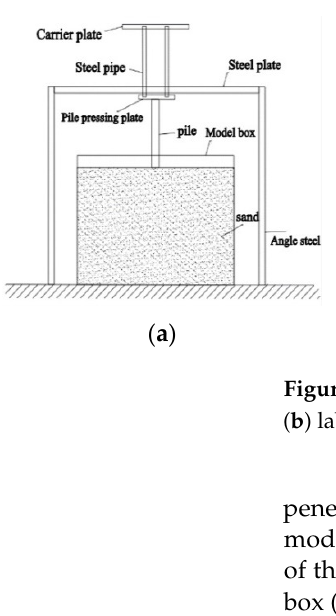
( c ) Figure 7. Site schematic diagram of large diameter pipe pile construction effect experiment, showing the ( a ) digital camera, ( b ) total station, and ( c ) self-made monitoring steel pole. The layouts of the digital cameras and the monitoring process were comparable to the dynamic monitoring test of the standard penetration of large-diameter tubular piles. Tripods and digital cameras were set at 13 m and 15 m in front of the monitoring steel bar. Further, total-station instruments were installed freely near the digital cameras. Before the construction of Pile #4, the initial image and initial spatial coordinates of the self-made steel bar were acquired by the digital cameras and total-station instruments, respectively. The images and spatial coordinates of the self-made steel bar were acquired regularly throughout construction. These steps were repeated in the construction of Pile #5. 3.3. Indoor Tests on the Construction Effect of Large-Diameter Tubular Piles The self-designed device was applied to simulate squeezed soils, the soil plug phe- nomenon, and the bearing capacity of open-ended tubular piles during settlement. The